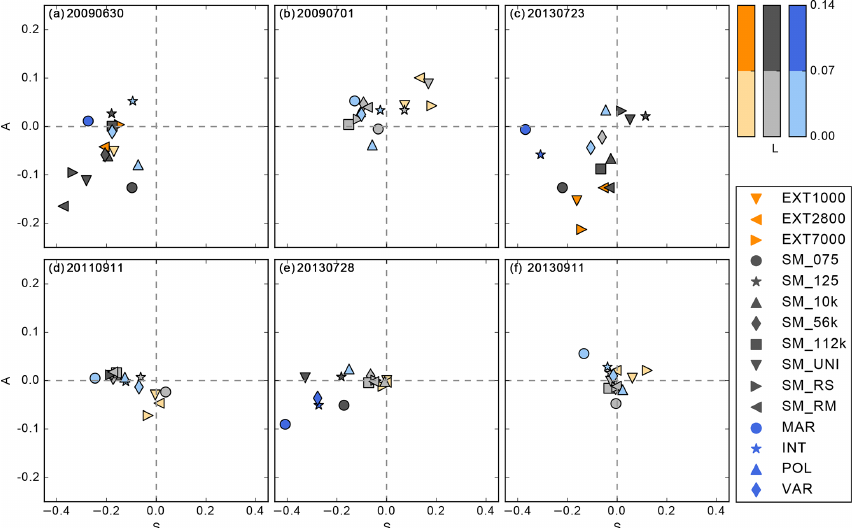
Figure 7. Mean SAL diagram showing the structure, amplitude, and location component for the 6 days of investigation averaged from hourly rainfall amounts. The more the values deviate from 0, the larger the deviation from the respective reference run is. An identical prediction would have values of 0 for each component. Note the different axes for A and S